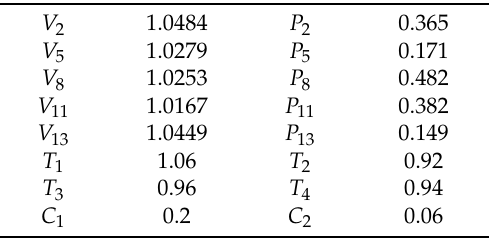
Table 2. The optimized system control parameters.